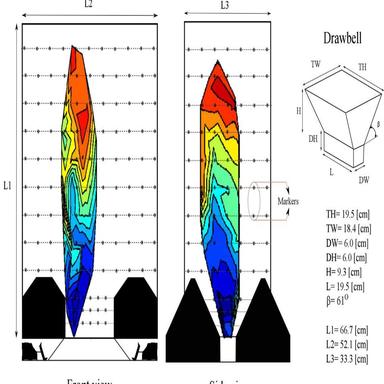
Experimental set-up – scale 1:75 - physical model, distribution of markers in ore column and drawbell dimensions.